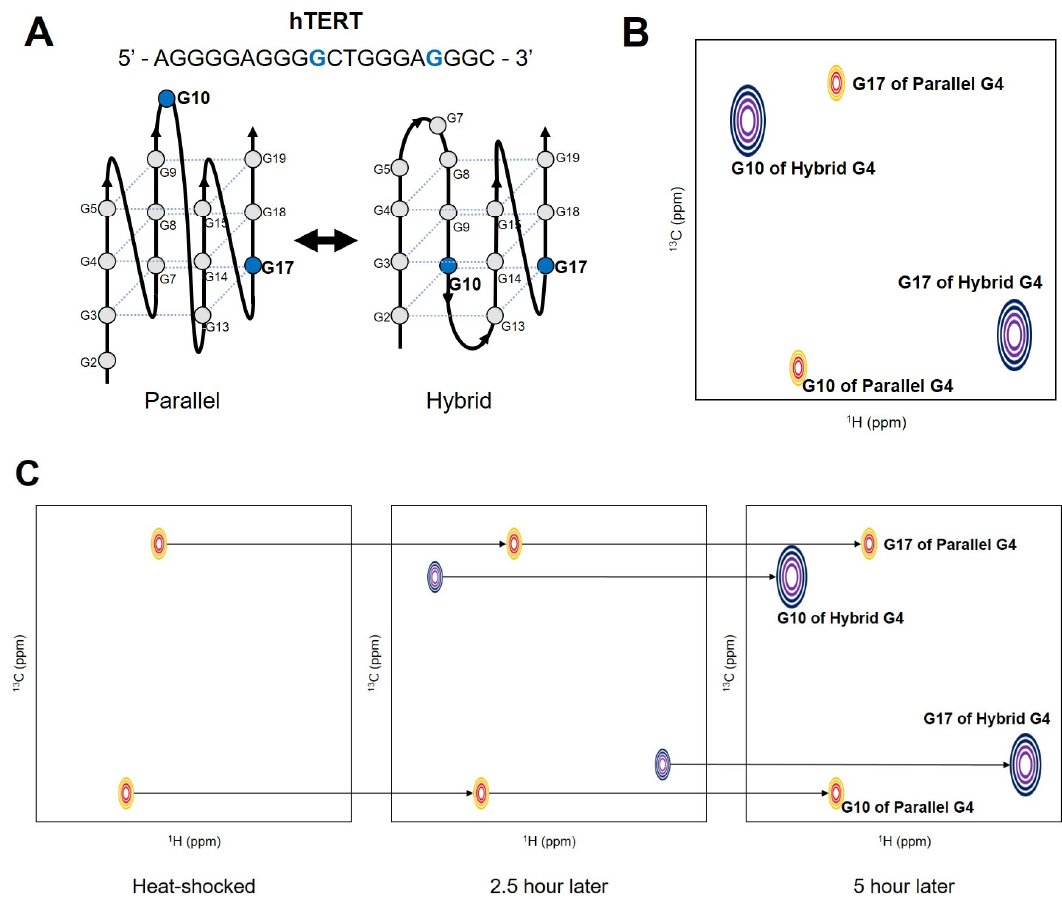
Figure 2. ( A ) G-register isomers of hTERT G4. The 13 C labeled G10 and G17 are shown in Blue. ( B ) Schematic drawing of 1 H- 13 C HSQC spectra of hTERT G4 with 13 C labeled G10 and G17. ( C ) Schematic drawing of NMR monitoring of the re-equilibration process. Redrawn from Ref. [27] by permission of Oxford University Press on behalf of Nucleic Acids Research.